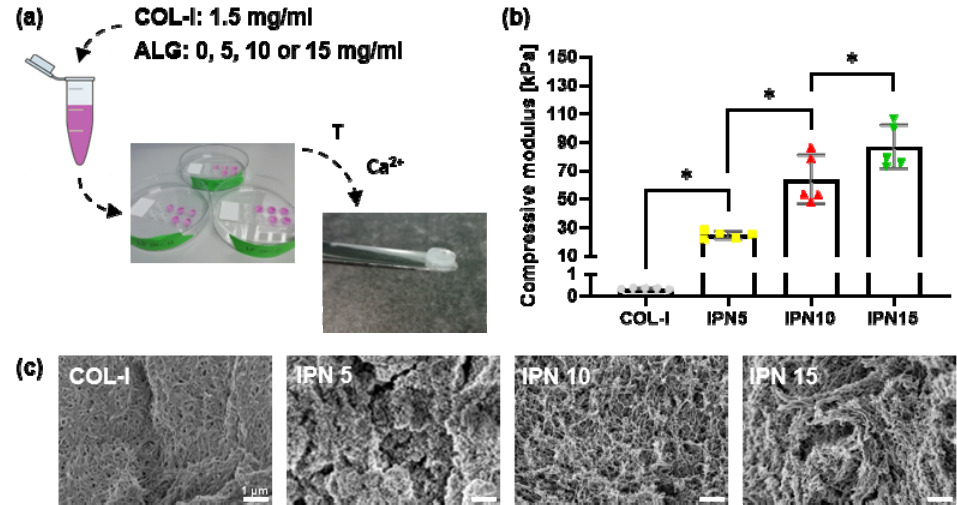
Figure 2. Fabrication of an IPN material mirroring the bone marrow/osteoid niche ( a ) Overview of the IPN synthesis with a 1.5 mg/mL collagen type I (COL-I) concentration and a varying alginate (ALG) concentration of 0, 5, 10, and 15 mg/mL subjected to a collagen type I gelation phase at 37 °C (T) for 30 min next to an ionic crosslinking (Ca 2+ ) phase of alginate at 37 °C for 3 h; ( b ) unconfined compressive modulus compared for four different materials: a collagen type I hydrogel (COL-I), a COL-I/ALG IPN hydrogel with 5 mg/mL alginate (IPN 5), a COL-I/ALG IPN hydrogel with 10 mg/mL alginate (IPN 10), and a COL-I/ALG IPN hydrogel with 15 mg/mL alginate (IPN 15) (n = 5); ( c ) SEM images of COL-I, IPN 5, IPN 10, and IPN 15 (scale bar: 1 μ m).